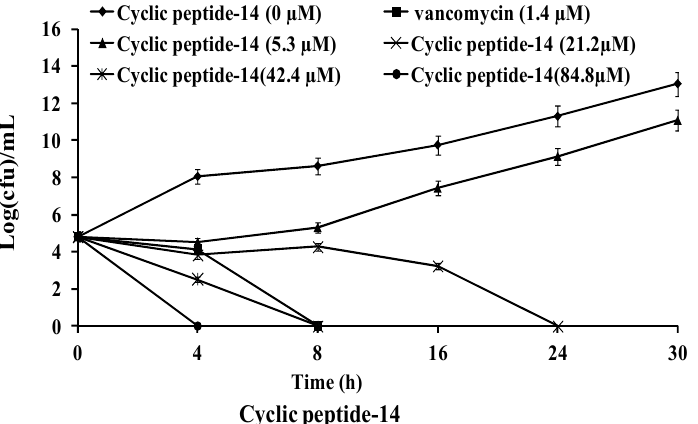
Figure 1. Time-kill curves of cyclic peptide-1, cyclic peptide-11, and cyclic peptide-14.